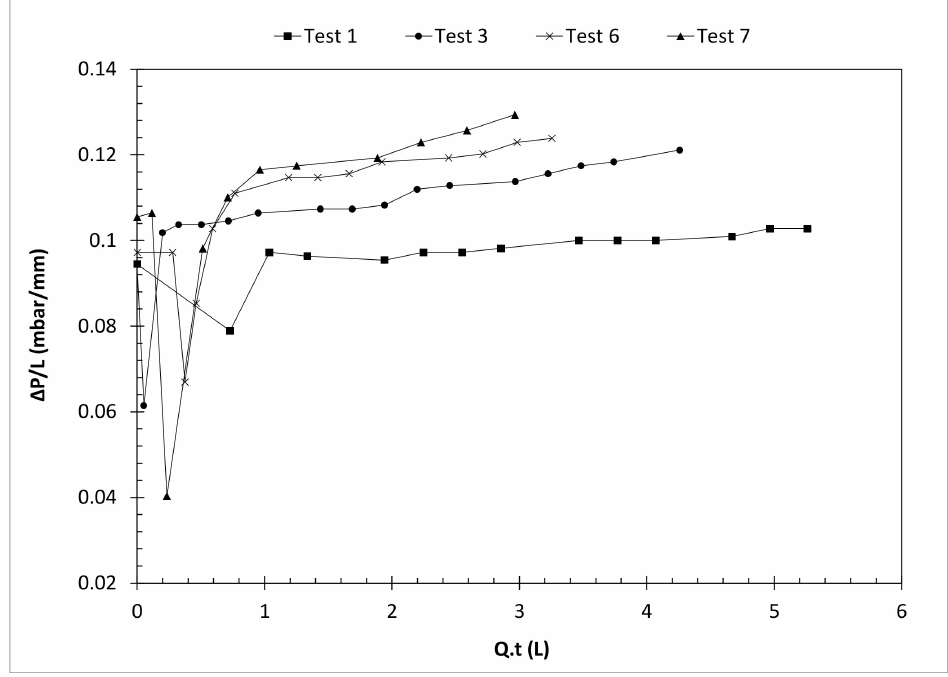
Figure 16. Pressure gradients in displacement flow tests in the eccentric Hele–Shaw cell. Comparison of pressure gradients of displacement flow tests in the cells with eccentric and concentric geometries [31] and with the same cross-sectional area is shown in Figure 17. Comparing the tests with the same used fluid in the concentric and eccentric